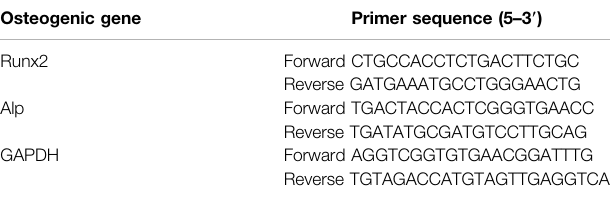
TABLE 2 | Primer sequences used for qRT-PCR analysis. Osteogenic gene Primer sequence (5 – 3 9